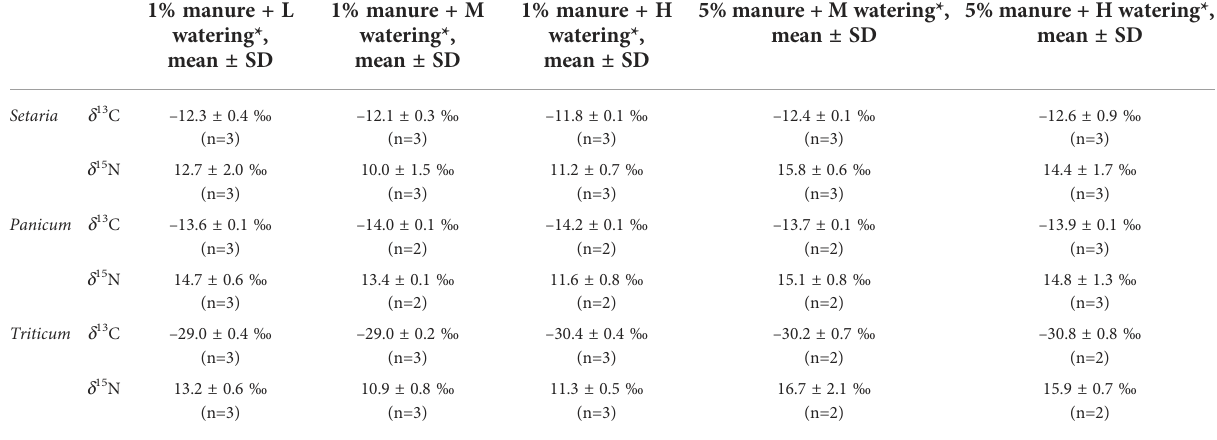
TABLE 2 The carbon and nitrogen isotope values of foxtail millet ( Setaria ), broomcorn millet ( Panicum ), and wheat ( Triticum ) grains grown under different manuring and watering